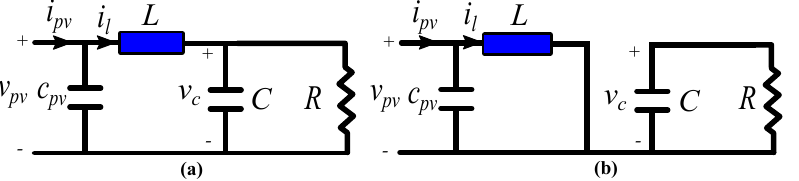
Figure 1. Equivalent circuit of the boost converter when: ( a ) switch is OFF, and ( b ) switch is